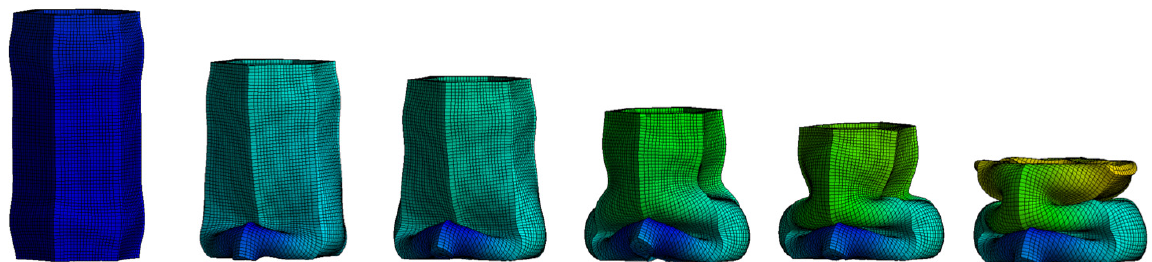
Figure 18. FE analysis of deformation process for the standard hexagonal cell under axial load.